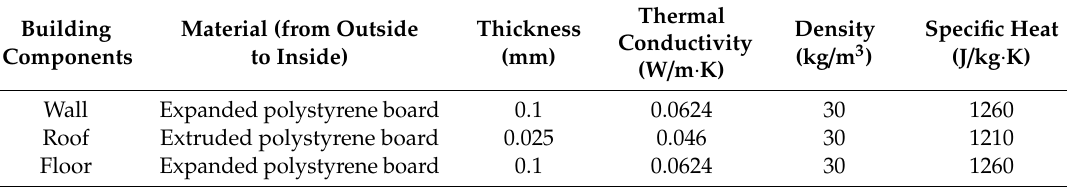
Table 2. Building materials and their thermophysical